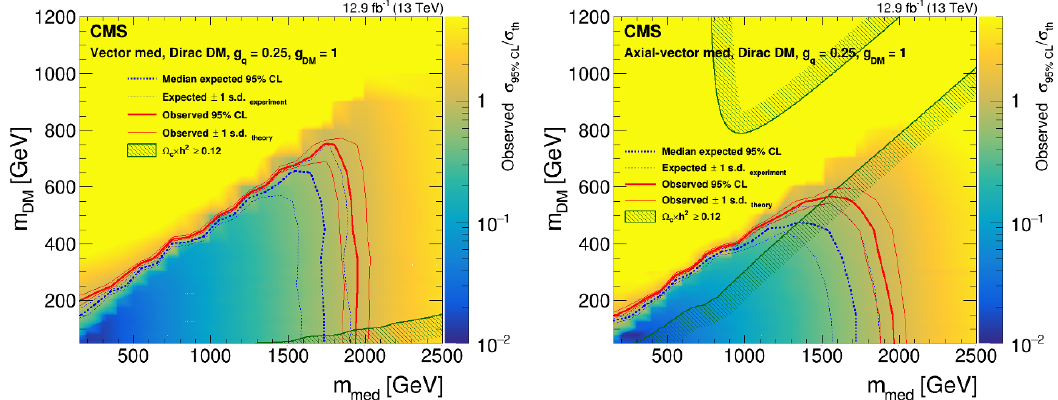
Figure 8 . Exclusion limits at 95% CL on the signal strength (cid:22) = (cid:27)=(cid:27) th in the m med - m DM plane assuming vector (left) and axial-vector (right) mediators. The limits are shown for m med between 150 GeV and 2.5 TeV, and m DM between 50 GeV and 1.2 TeV. While the excluded area is expected to extend below these minimum values of m med and m DM , the axes do not extend below these values as the signal simulation was not performed in this region. The solid (dotted) red (blue) line shows the contour for the observed (expected) exclusion. The solid contours around the observed limit and the dashed contours around the expected limit represent one standard deviation theoretical uncertainties in the signal cross section and the combination of the statistical and experimental systematic uncertainties, respectively. Constraints from the Planck satellite experiment [83] are shown with the dark green contours and associated hatching. The hatched area indicates the region where the DM density exceeds the observed